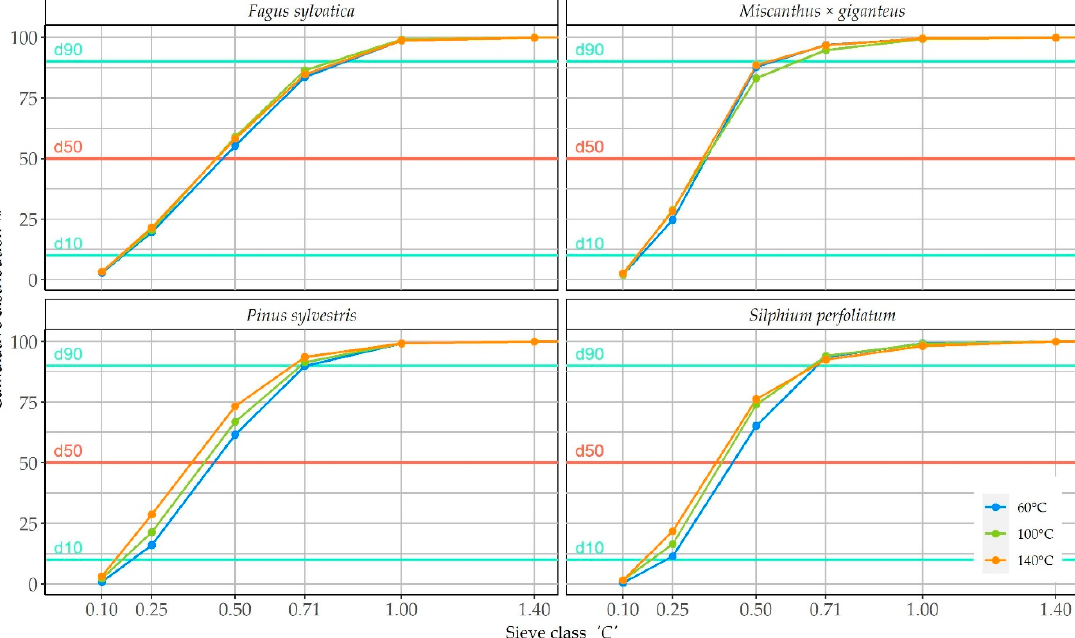
Figure 4. Cumulative particle size distribution (cPSD) raw materials ground with the hammer milling system. Figure 5 presents a comparison of the d 50 analysis of all samples. In general, the lowest values of this parameter were for Miscanthus. This indicates that this material, during milling, produces the majority of fine particles (mean value of d 50 of all samples is 0.34 mm). Slightly coarser particles would be obtained for Pinus and Silphium ( d 50 —0.39 mm) and for Fagus ( d 50 —0.44 mm). Comparing the milling systems in most cases, the sample ground on the hammer system had a lower d 50 compared to that milled on the knife system. The only exception was Miscanthus dried at 60 °C, where the trend was reversed. A similar trend was observed by Kirsten et al. by studying grass (hay) grindability [72].